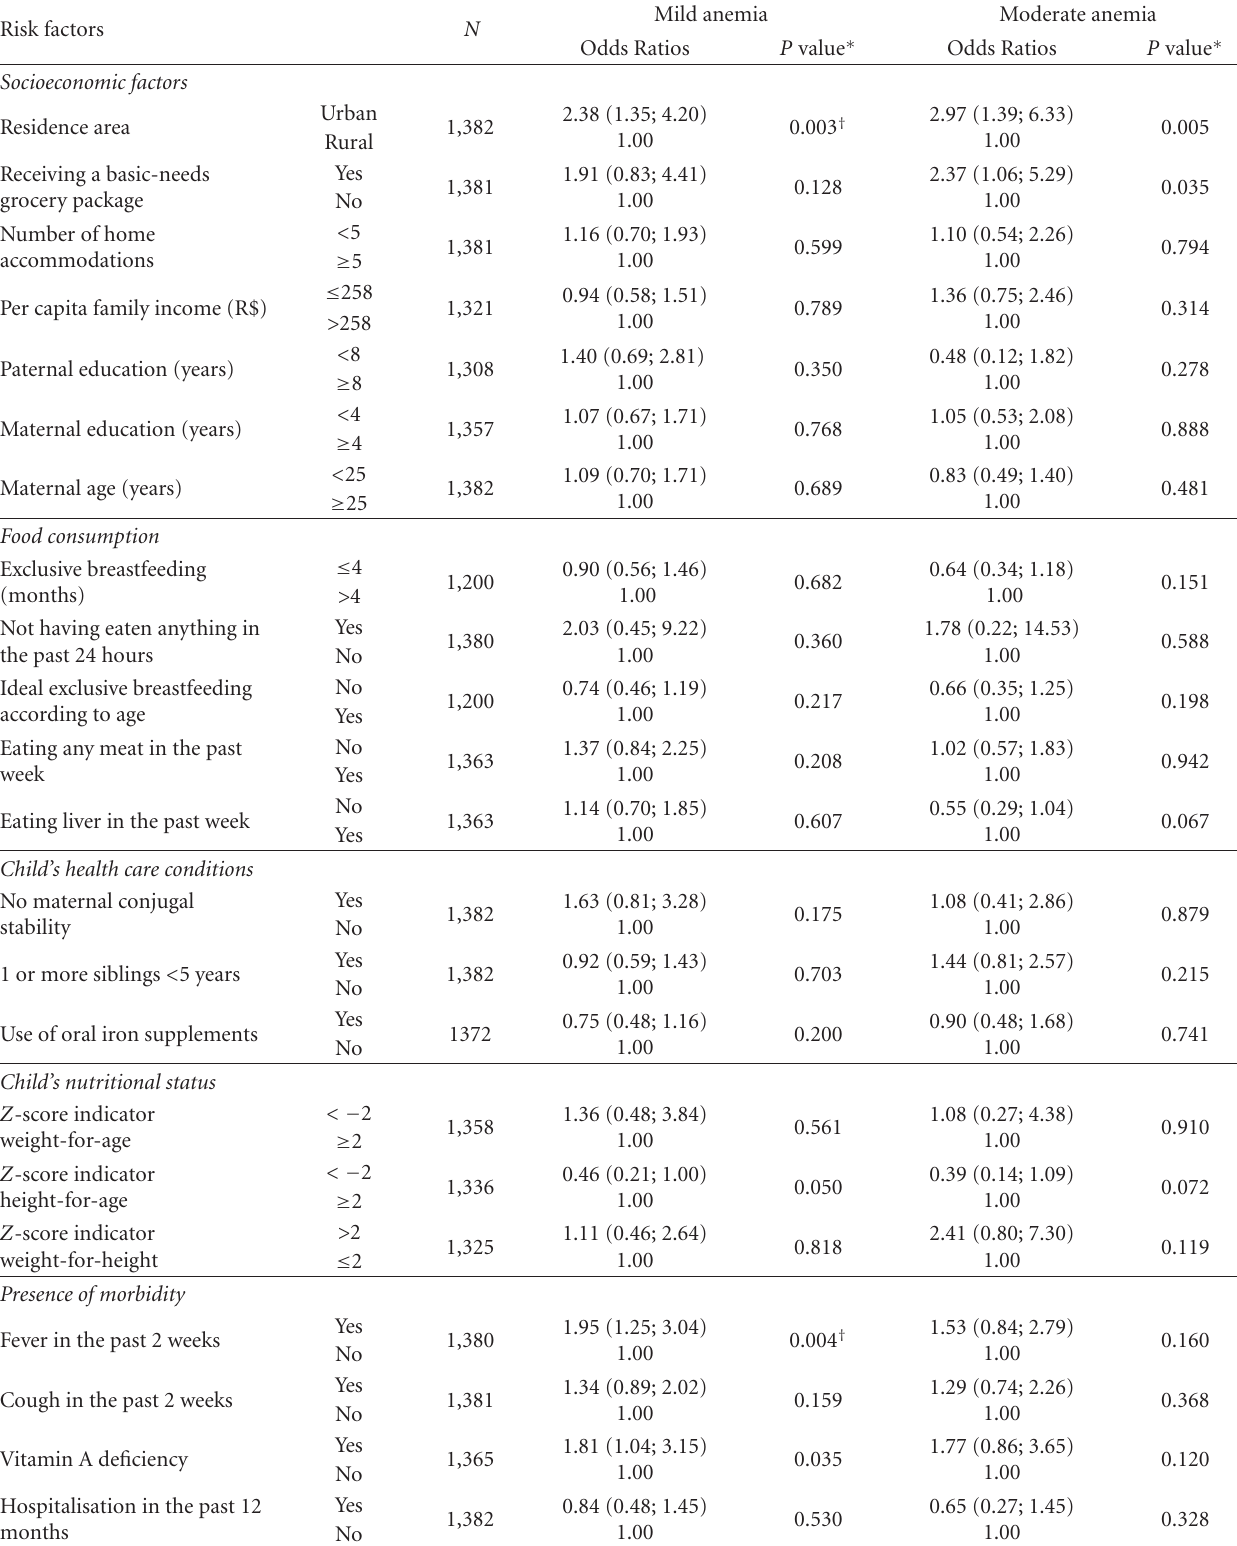
Table 2: Odds ratios of risk factors for mild anemia (Hb < 11.0g/dL) and moderate anemia (Hb < 9.5 g/dL) of children younger than 24 months old who participated in the Brazilian National Survey on Demography and the Health of Women and Children (PNDS 2006), with their respective confidence intervals (CI